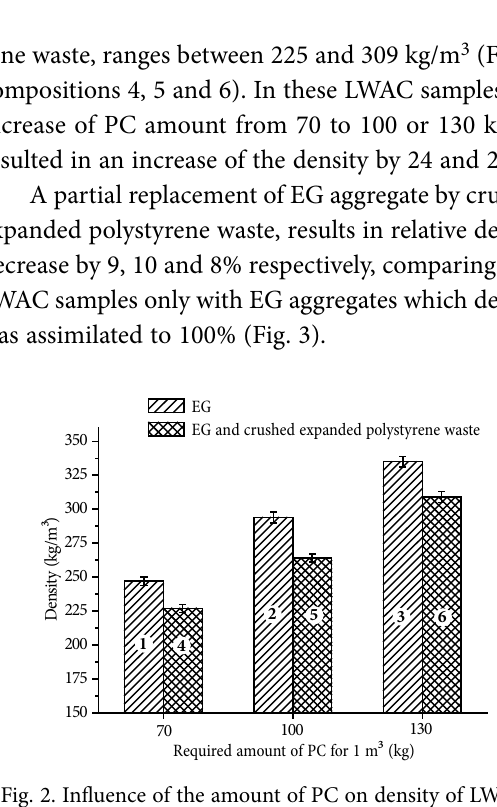
Fig. 1. View of lightweight aggregate composite: a – with EG aggregate; b – with mixed aggregate; c – contact zone between EG granules; d – contact zone between EG and crushed expanded polystyrene waste particle